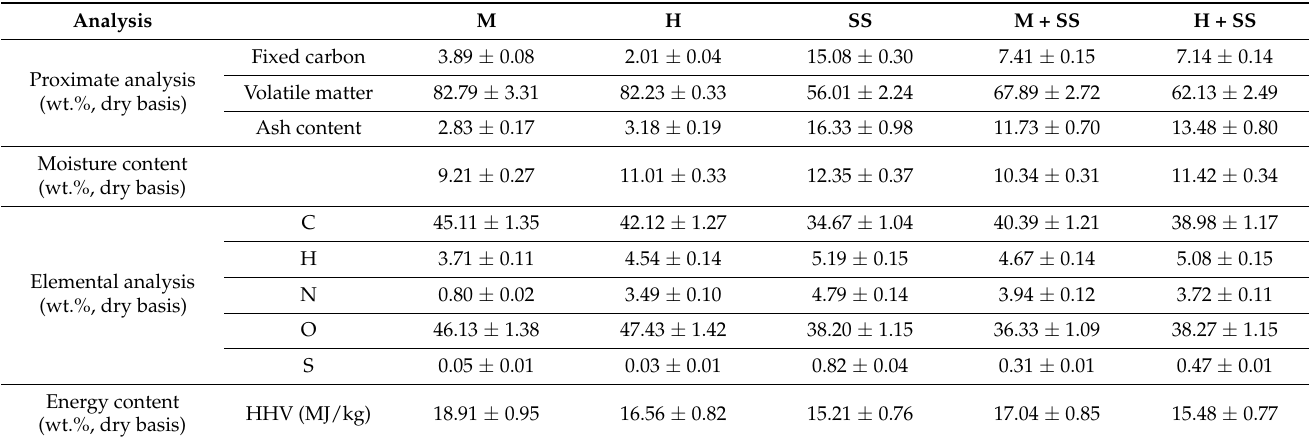
Table 3. Physicochemical properties of raw biomass samples.